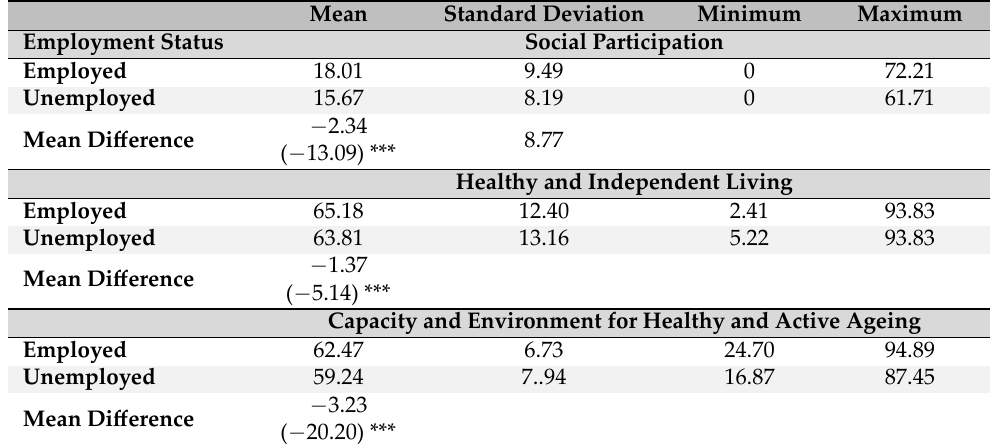
Table 4. T‑tests Comparing the Values of the HAAI Components depending on the Employment Status.